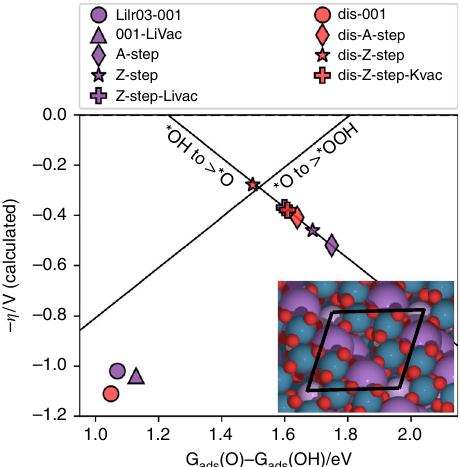
Fig. 5 Calculated OER overpotential ( η ) as a function of G ads (O) – G ads (OH). Calculations for various surface sites on markers) and Li 0.75 K 0.25 (H 2 O) 0.50 IrO 3 (red markers; see Supplementary Materials for further details on the structure of the various sites). Black lines indicate the volcano de fi ned by the scaling relations between the adsorption energies of the ∗ OH, ∗ O, and ∗ OOH intermediates. The inset shows the structure of the Z-step of the intercalated structure with the computational unit cell marked by black lines. (Ir is bluish gray, Li is pink, O is red, H is white, and K is